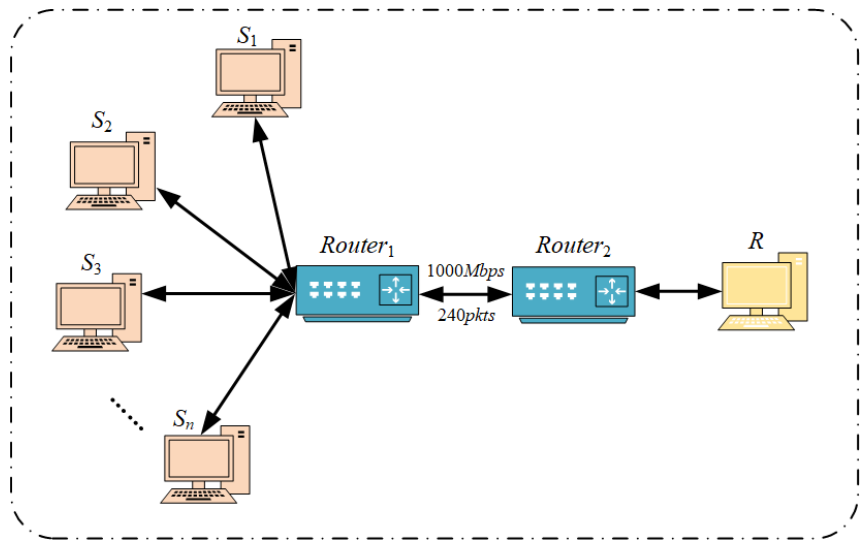
Figure 4. The overall design idea of HDCQ